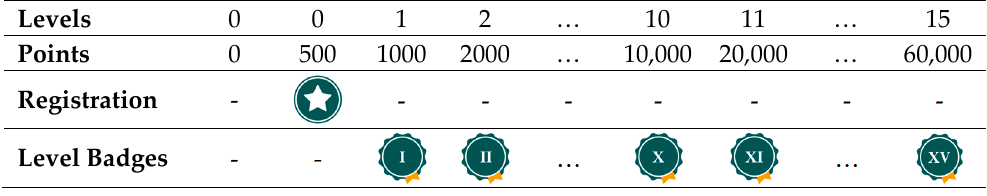
Table A4 indicates the relationship between repeated activities and badge awards. A tally of activities is to be kept within a user’s personal account. Badges are awarded at each milestone. Table A4. Gamification–badge